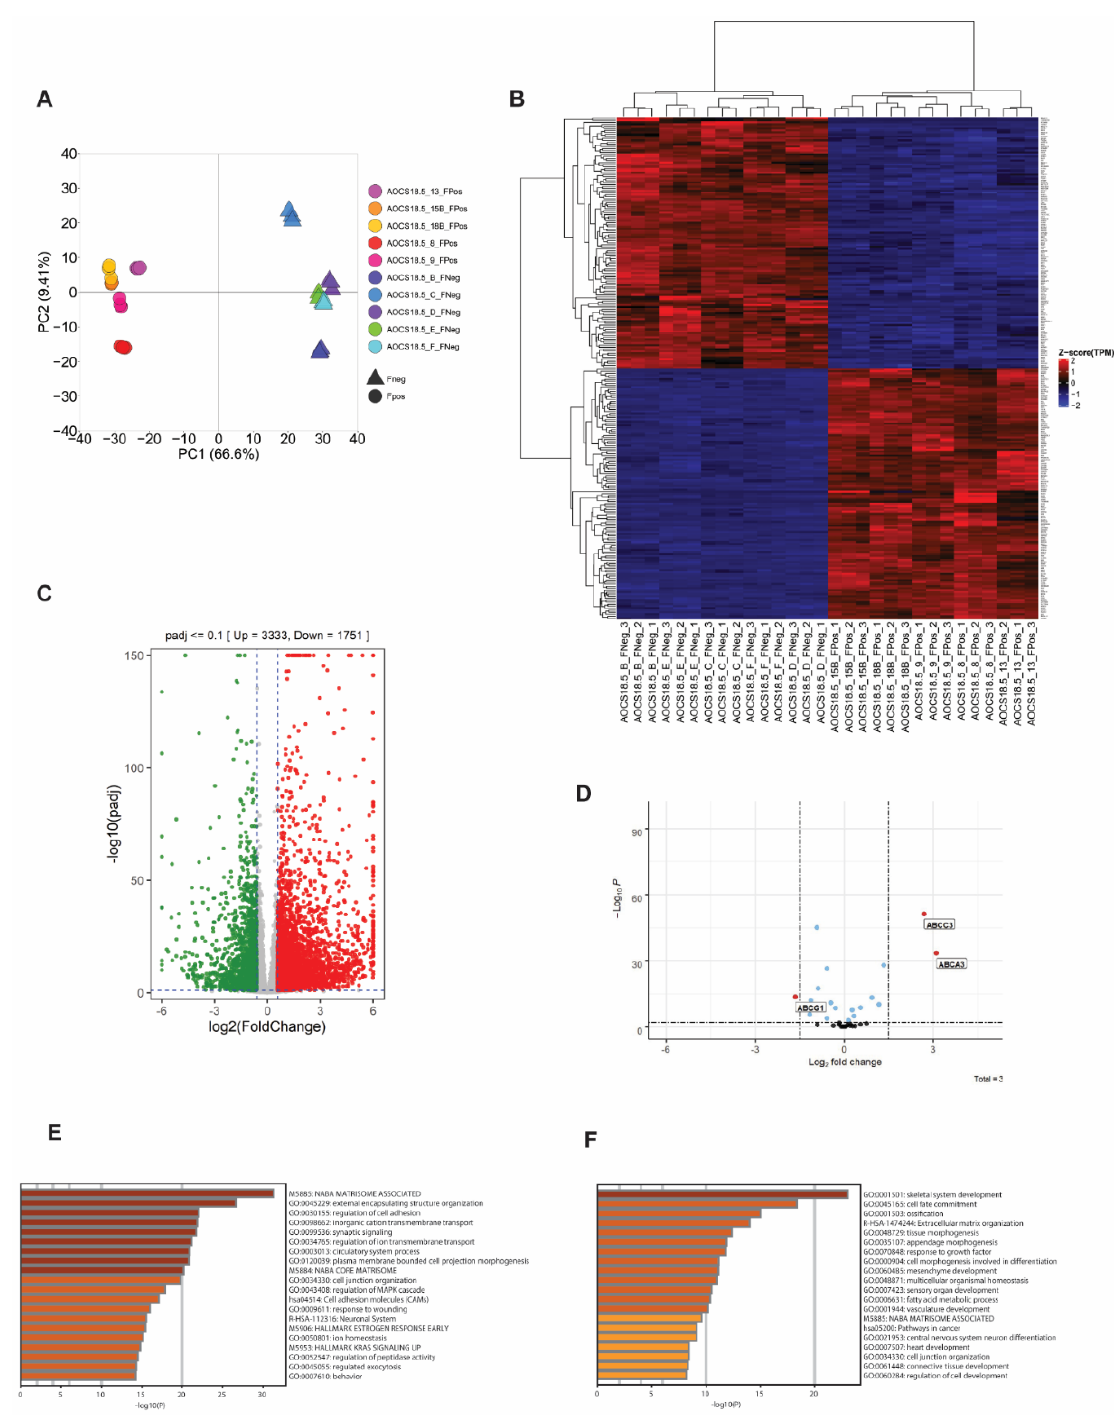
Figure 2. SLC25A40-ABCB1 fusions induce strong enrichment for matrisome-associated genes. ( A ) Principal Component Analysis (PCA) of gene expression data for ABCB1 fusion-negative (5 clones, triangle) and fusion-positive (5 clones, circle) cell lines. ( B ) Unsupervised hierarchical clustering analysis of the transcriptional profile of SLC25A40-ABCB1 fusion-negative (FNeg, n = 5) and fusion-positive (FPos, n = 5) AOCS18.5 single-cell clones. The top 250 significantly differentially expressed genes from RNAseq analysis are shown ( p -adj <0.1). ( C ) Volcano plot showing significantly up/downregulated differentially expressed genes in fusion-positive clones compared to fusion-negative. Cut-off criteria was log 2 fold change of 1.5 and p -adj of <0.1. ( D ) Identification of ABC family members modulated by SLC25A40-ABCB1 fusions in addition to ABCB1 . Cut-off criteria was log 2 fold change of 1.5 and p -adj of <0.1. Metascape analysis of pathways enriched ( E ) and repressed ( F ) in AOCS18.5 fusion-positive